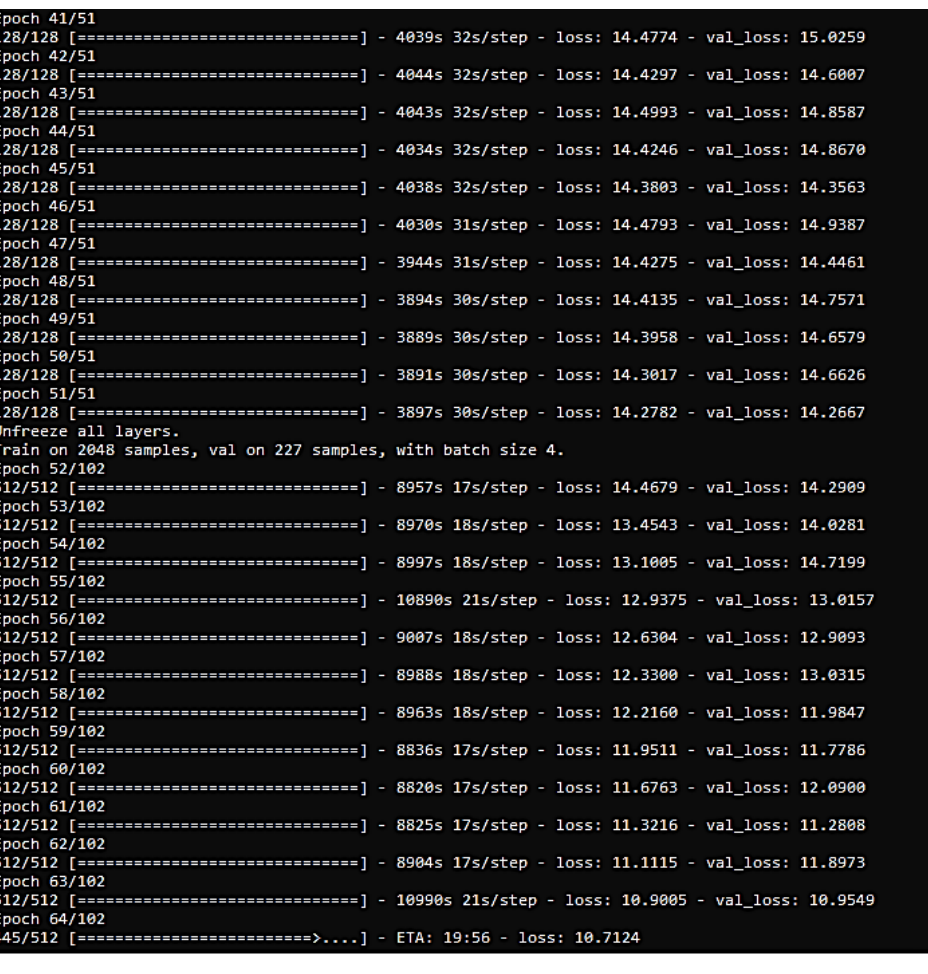
Figure 8. Image of YOLO training process